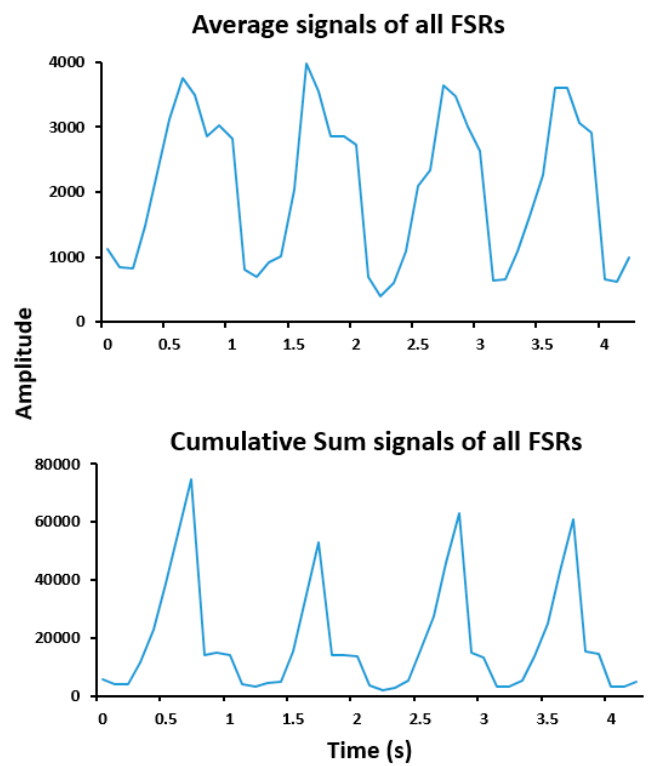
Figure 3. Examples of average and cumulative sum of all FSR signals obtained from one participant.